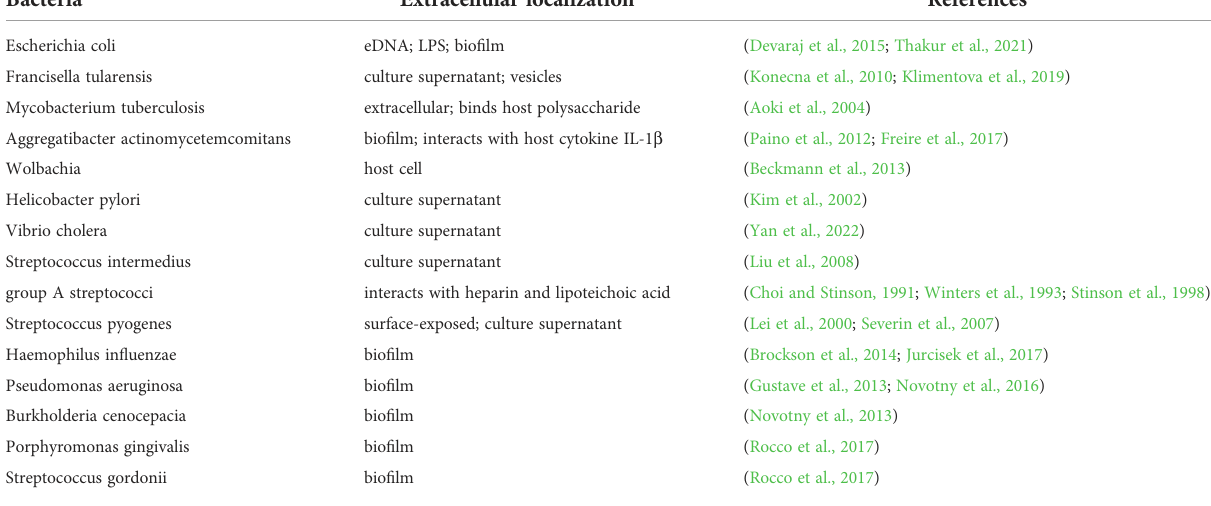
TABLE 1 List of bacterial species secreting HU protein (or HU homologue).